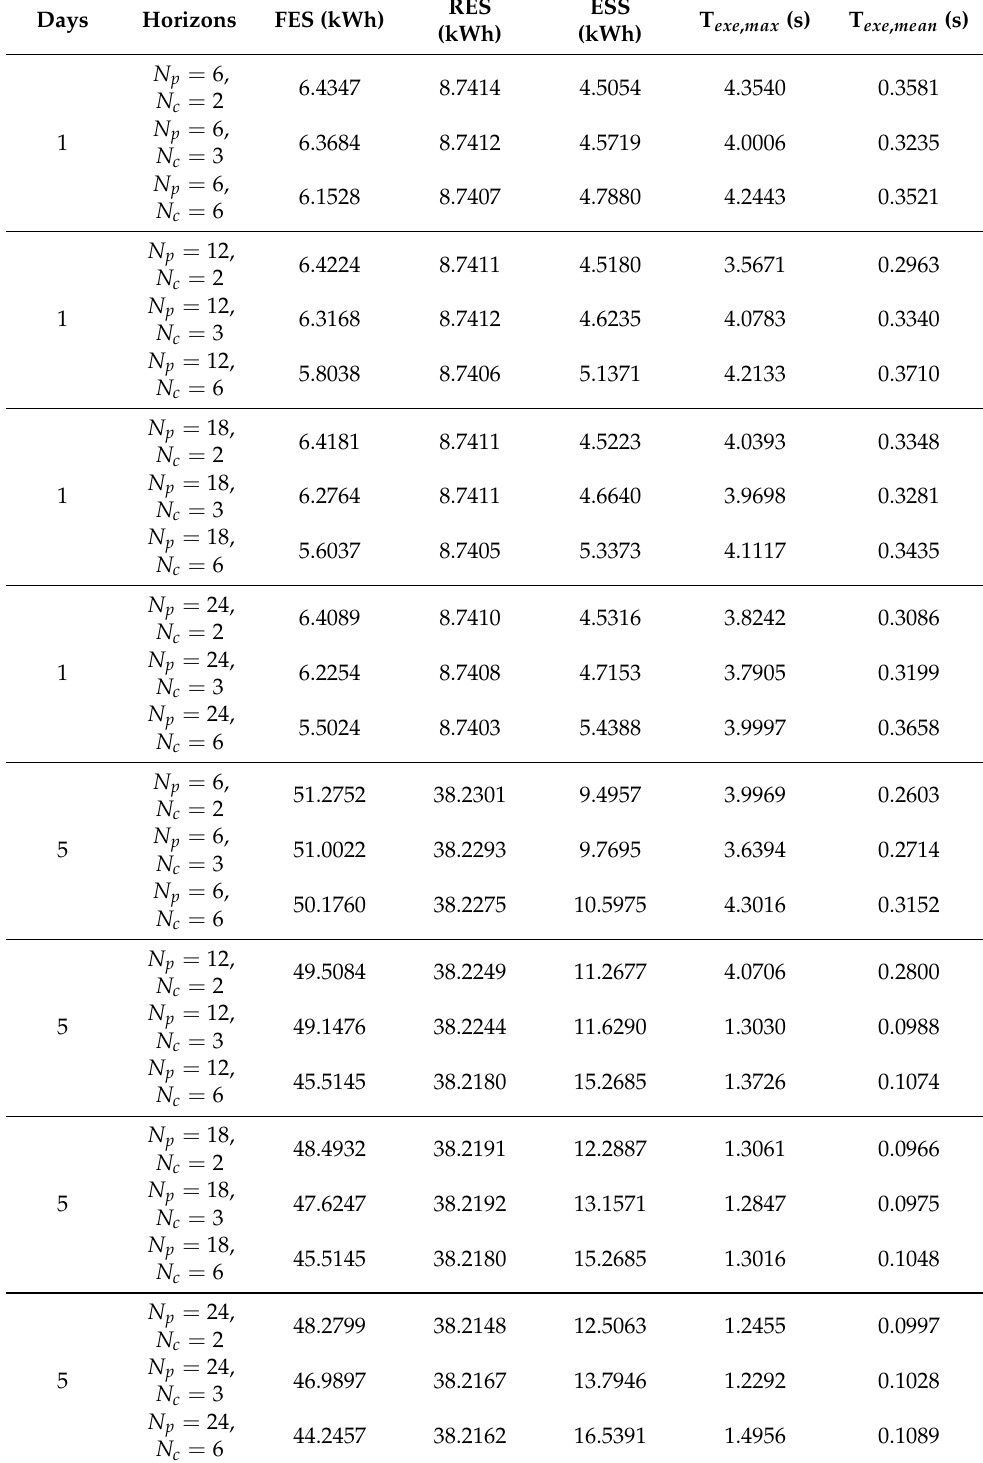
Table 1. Energy supplied in one and five